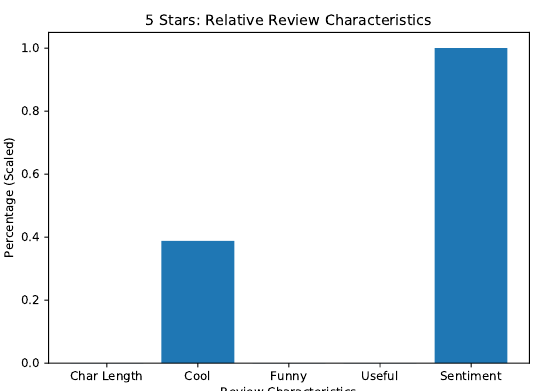
Figure A9. Results from analysis “Review Trends in Phoenix 2018”. Displayed are relative characteristics of 5 star reviews over reviews of restaurants in Phoenix 2018.